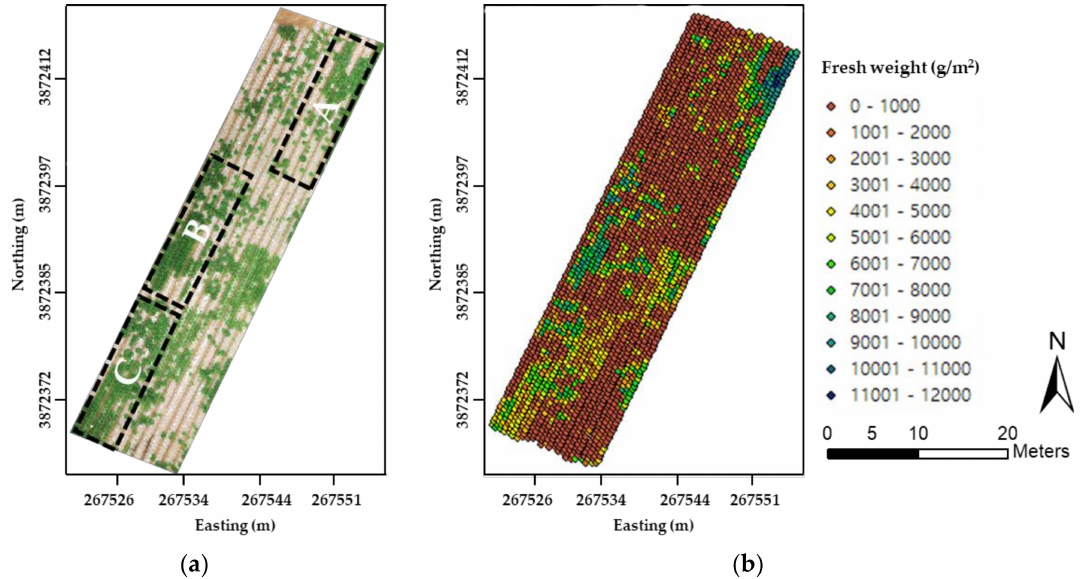
Figure 14. ( a ) Unmanned aerial vehicle-red, green and blue (UAV-RGB) orthomosaic image of Chinese cabbage collected on 27 October 2016 and ( b ) fresh weight map of Chinese cabbage generated using the developed regression models applied to the UAV-RGB image. The capital letters A, B, and C represent the subplots showing the growth of Chinese cabbage transplanted on different